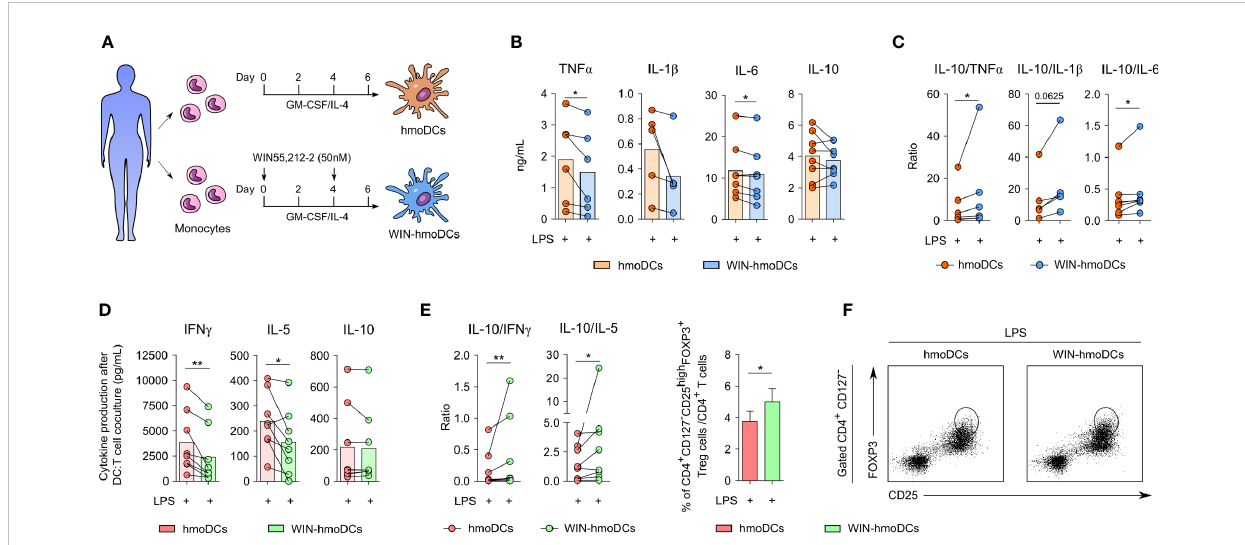
FIGURE 1 WIN-hmoDCs display anti-in fl ammatory and tolerogenic properties upon LPS stimulation. (A) Differentiation protocol of hmoDCs and WIN-hmoDCs from monocytes. (B, C) cytokine production (B) and ratios (C) of conventional hmoDCs and WIN-hmoDCs after LPS stimulation (100 ng/mL) (n=5- 8). (D E) cytokines (D) and ratios (E) produced by allogeneic naive CD4 + T cells primed by LPS-stimulated hmoDCs or WIN-hmoDCs after 5 days of coculture (n=8). (F) Percentage (left), and representative dot plots (right) of induced CD4 + CD25 high CD127 - FOXP3 high Tregs by allogeneic LPS- stimulated hmoDCs or WIN-hmoDCs (n=7). Values are shown as mean ± SEM. Statistical signi fi cance was determined by Paired t test (B, D, F) or Wilcoxon test (C, E) . *P<0.05,